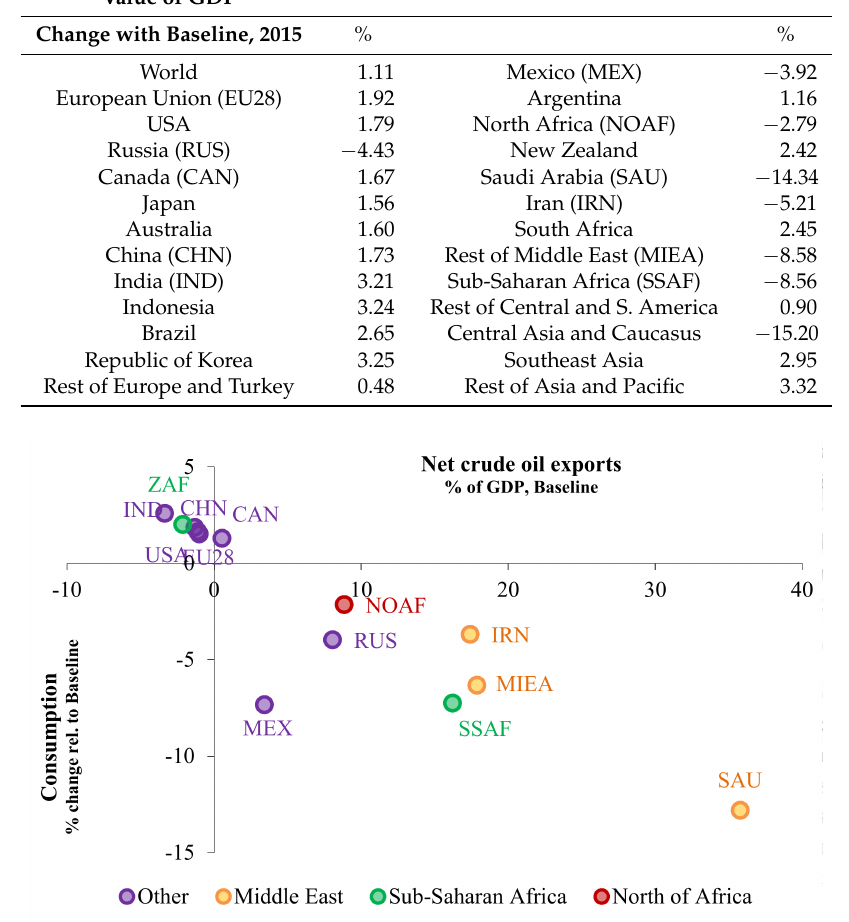
Figure 9. The impact of the low oil price on consumption vs. export dependence. Source: JRC-GEM-E3 model. Abbreviations: 28 Member States of the European Union (EU28), North Africa (NOAF), Sub-Sahara Africa (SSAF), Rest of Middle East (MIEA).